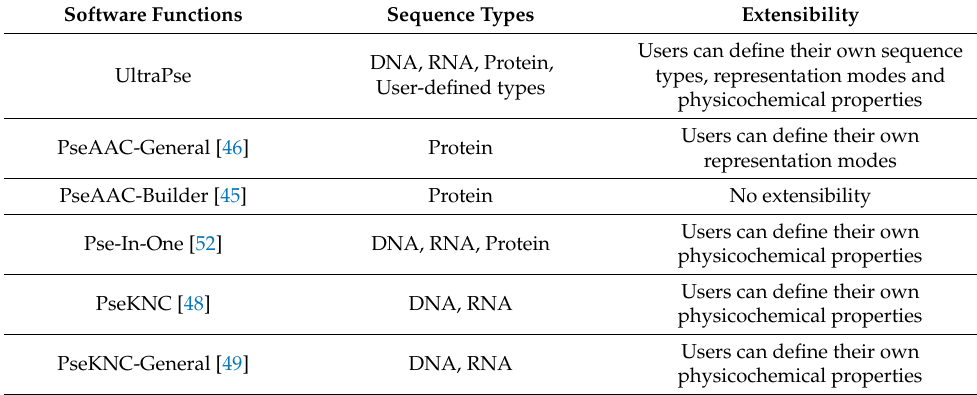
Table 1. Software function comparison in terms of flexibility and extensibility.